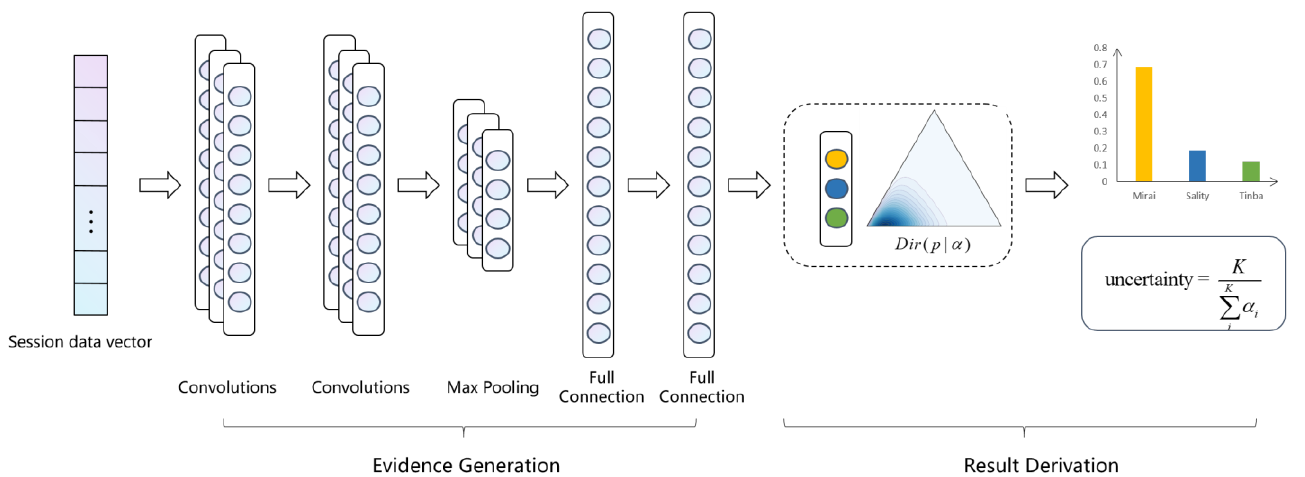
Figure 2. The structure of the DEMTR model.